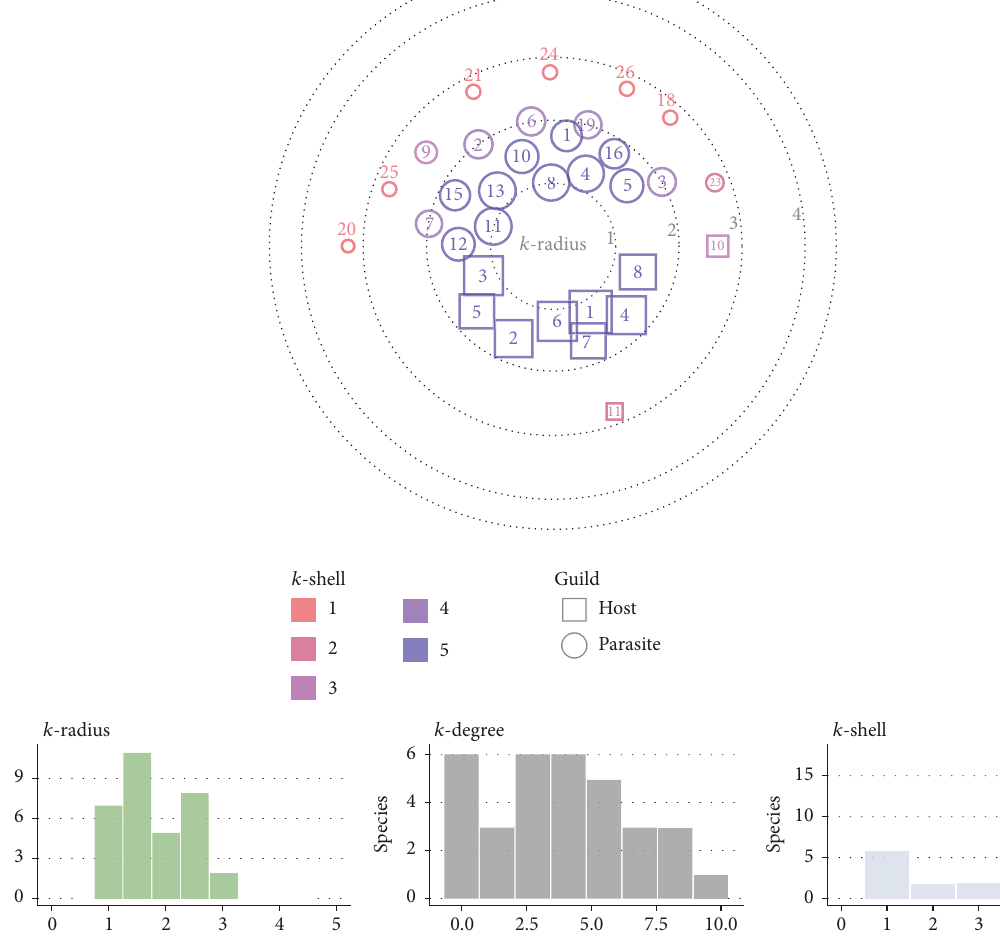
Figure 2: Polar plot of a host-parasite assembly in Tyva (Russian Federation) with the histograms of 𝑘